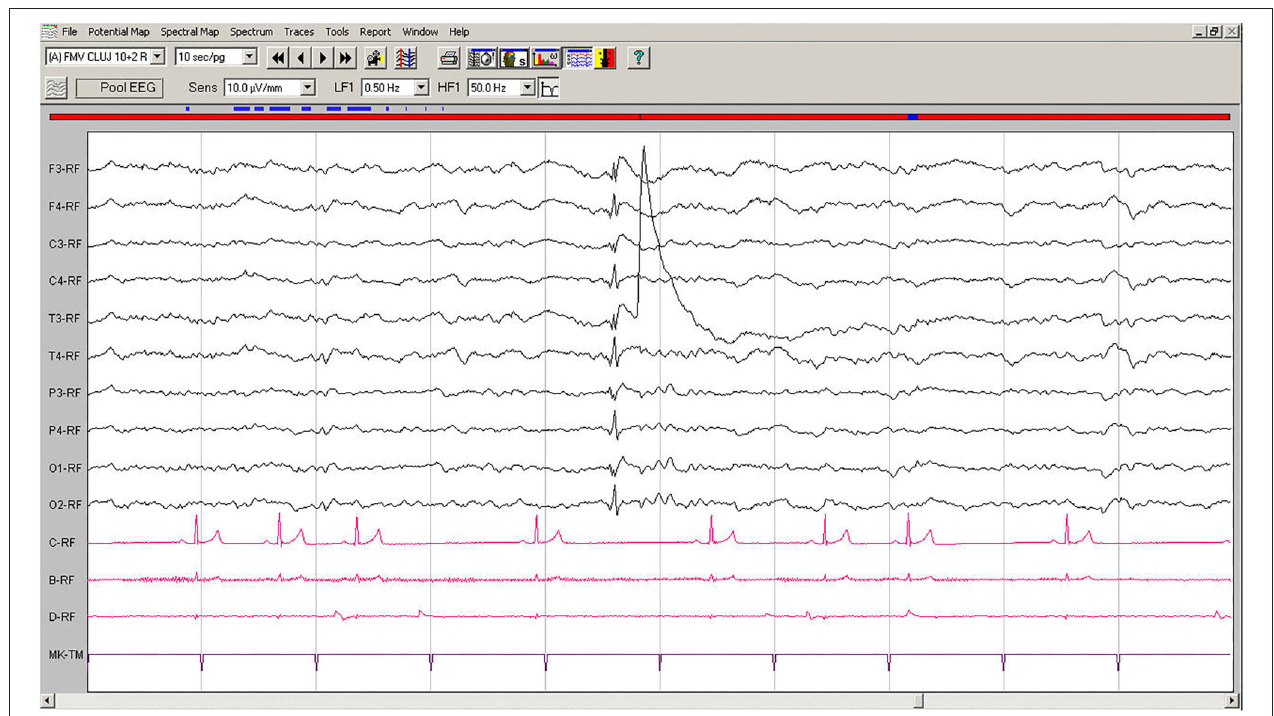
FIGURE 3 | Spontaneous EEG recording of Case No. 2 patient (7-year old male Beagle): In the fifth second, a generalized spike, visible on all derivations, is followed by slow waves. A muscle artifact can be seen after the discharge on T3. Low-cut filter: 0.5Hz; high-cut filter: 50Hz; speed 10 sec/page; channel C: ECG: bipolar on the chest, channel B: bipolar, left brachiocephalic muscle; channel D: bipolar, right brachioradialis muscle. EEG, electroencephalogram; ECG,